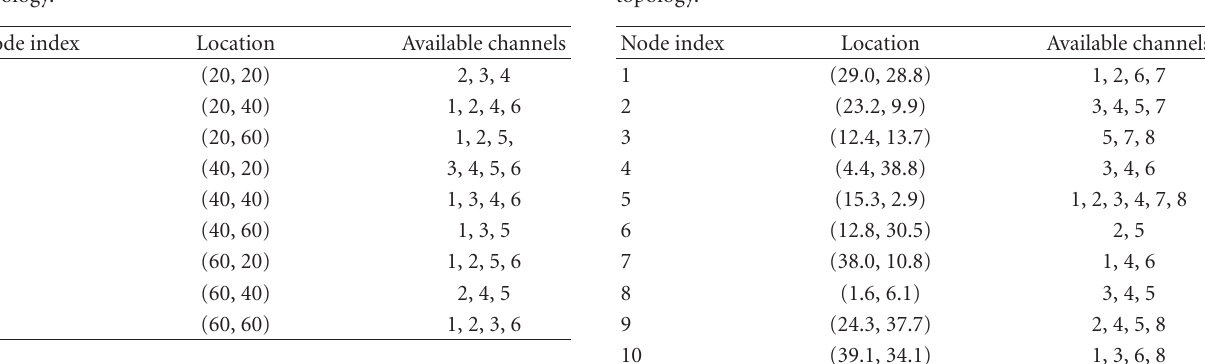
Table 2: Set of available channels at each node (i.e., C i ) for regular topology.